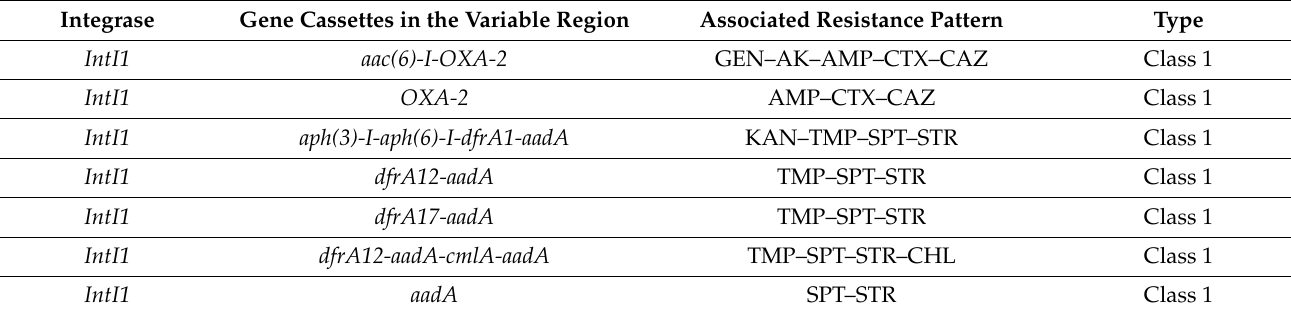
Table 2. Antimicrobial resistance genes detected among integrons identified in whole-genome sequenced isolates of Salmonella enterica from countries of the Andean Community according to I-VIP